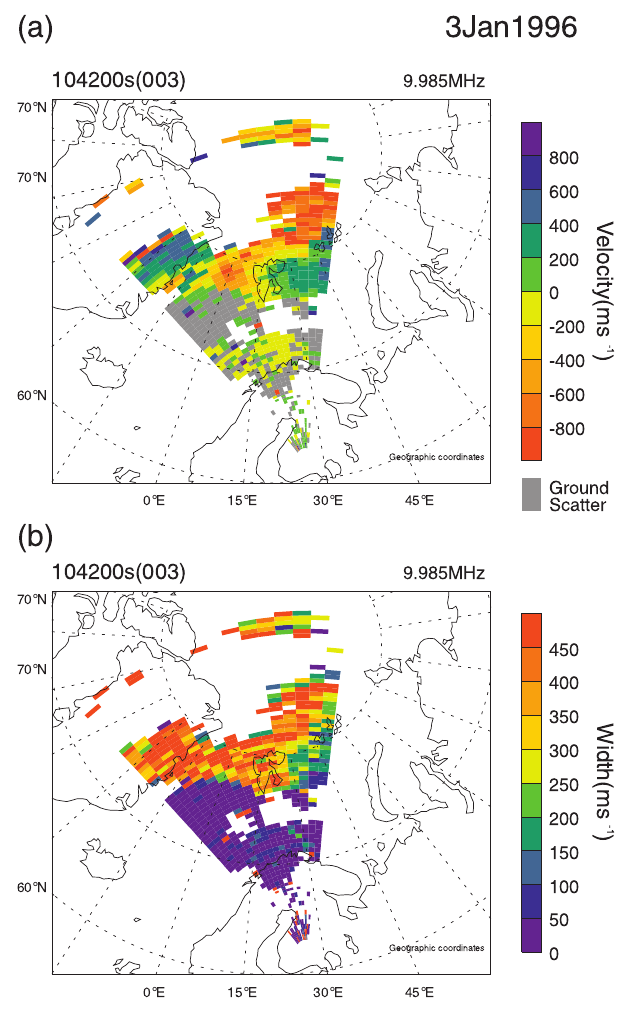
Fig. 2. a The single-scan line-of-sight velocity data measured by the CUTLASS Finland radar between 10:42 and 10:44 UT, 3 January, 1996. The co-ordinates are geographic and the colour scale is such that negative velocities ( red-yellow ) signify motion away from the radar. b The single-scan spectral width plot from 10:42 to 10:44 UT, 3 January,